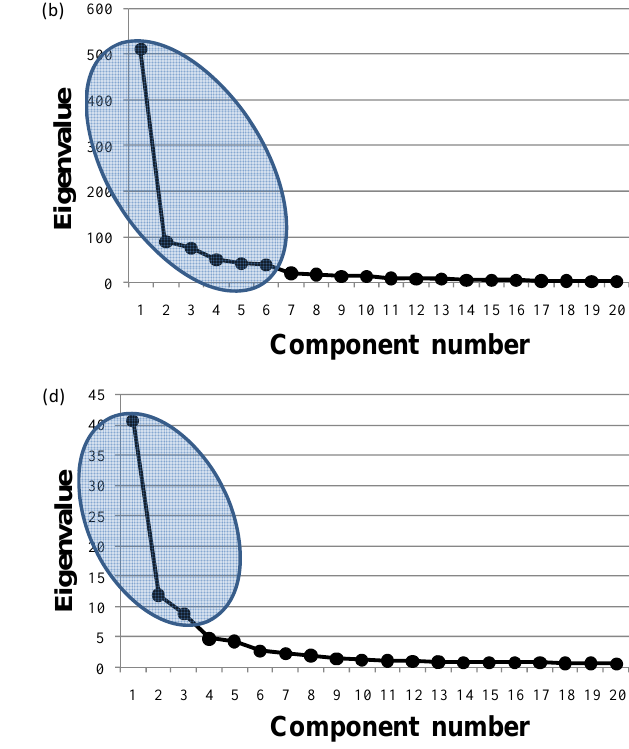
Fig. 4. Scree test of the eigenvalues obtained from each grid: (a) SLP, (b) T850, (c) Z500 and (d) Wind Velocity. Shaded area corresponds Fig. 4: Scree test of the eigenvalues obtained from each grid: a) SLP, b) T850, c) Z500 577 Fig. 4: Scree test of the eigenvalues obtained from each grid: a) SLP, b) T850, c) Z500 577 Fig. 4: Scree test of the eigenvalues obtained from each grid: a) SLP, b) T850, c) Z500 577 Fig. 4: Scree test of the eigenvalues obtained from each grid: a) SLP, b) T850, c) Z500 577 to one significant slope and d) Wind Velocity. Shaded area corresponds to one significant slope change. 578 and d) Wind Velocity. Shaded area corresponds to one significant slope change. 578 and d) Wind Velocity. Shaded area corresponds to one significant slope change. 578 and d) Wind Velocity. Shaded area corresponds to one significant slope change. 578